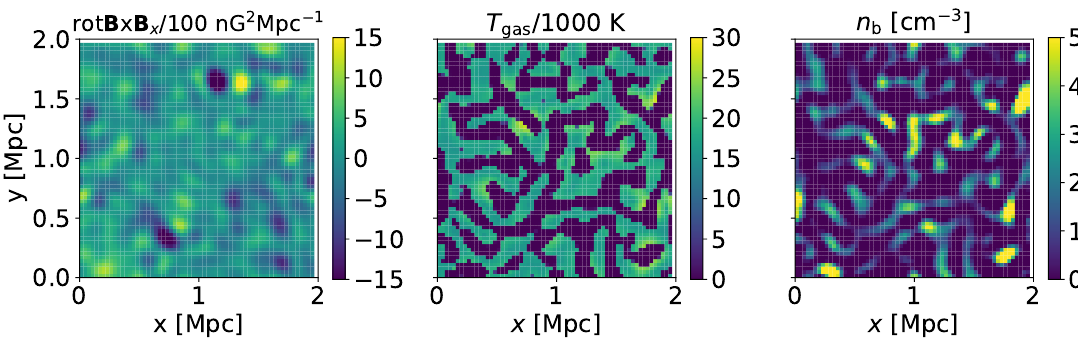
Figure 1. Illustration of ( ∇ × B ) × B x (left), the gas temperature (middle), and the gas number density (right) when z = 10. You can see the spatial anti-correlation between T gas and n b .